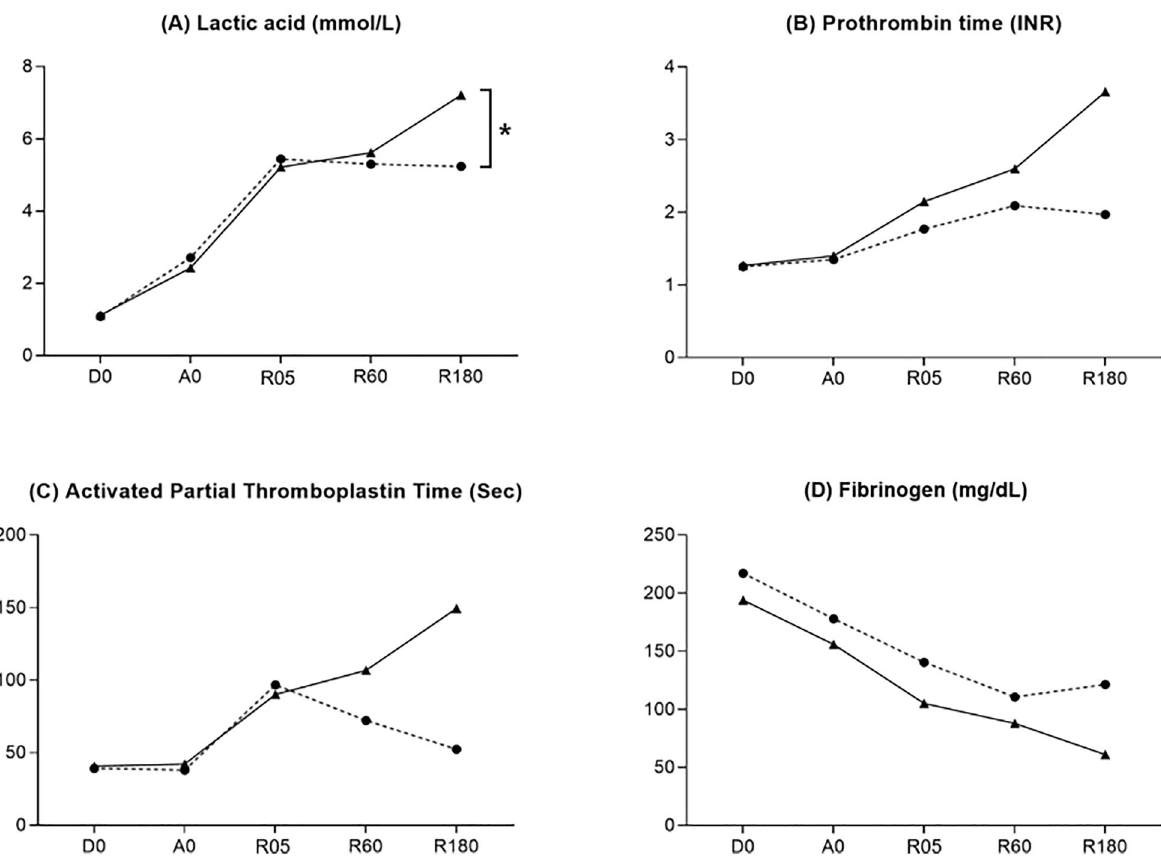
Figure 4. Changes of lactate and coagulation profile of non-prewarming group (straight line) and prewarming group (dotted line). The start of the dissection phase [D0], start of the anhepatic phase [A0], 5 min after graft reperfusion [R05], 60 min after graft reperfusion [R60], and 180 min after graft reperfusion [R180]. *Statistically significant ( P < 0.05) between